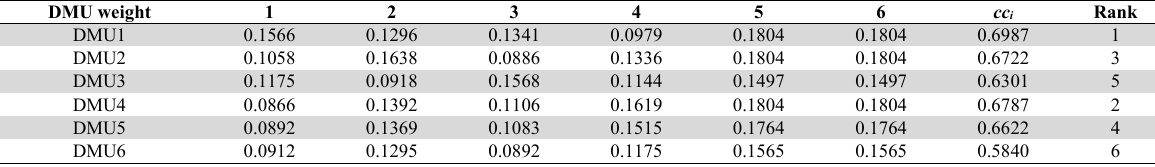
The rating and ranking of the proposed method for six nursing homes DMU weight 1